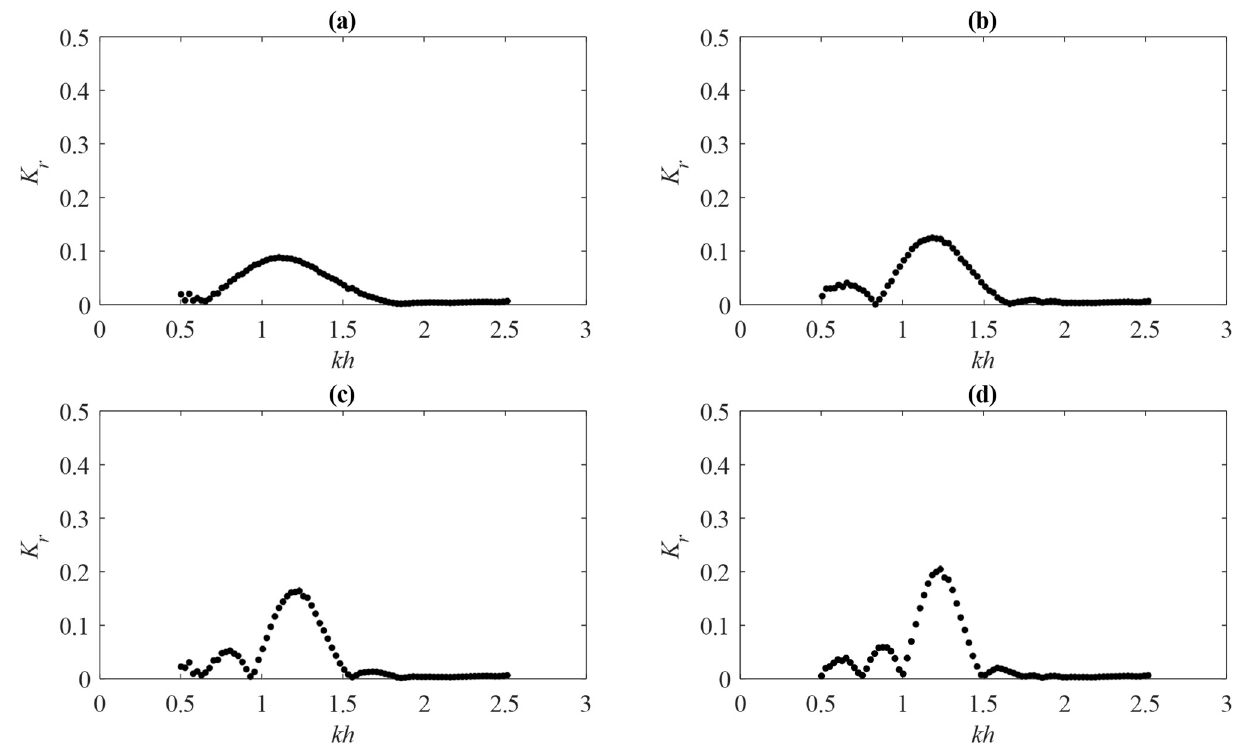
Figure 13. Reflection coefficient of multiple periodically submerged breakwaters with 1.0 m wave- length at 0.4 m water depth: ( a ) 𝑁 = 2 ( b ) 𝑁 = 3 ( c ) 𝑁 = 4 ( d ) 𝑁 = 5 .